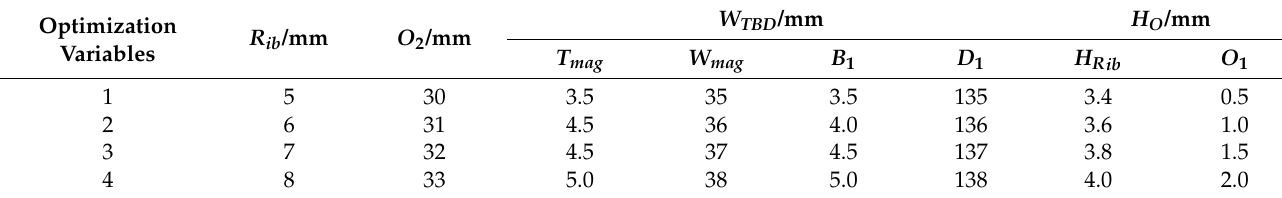
Table 3. Optimization level of different parameters.